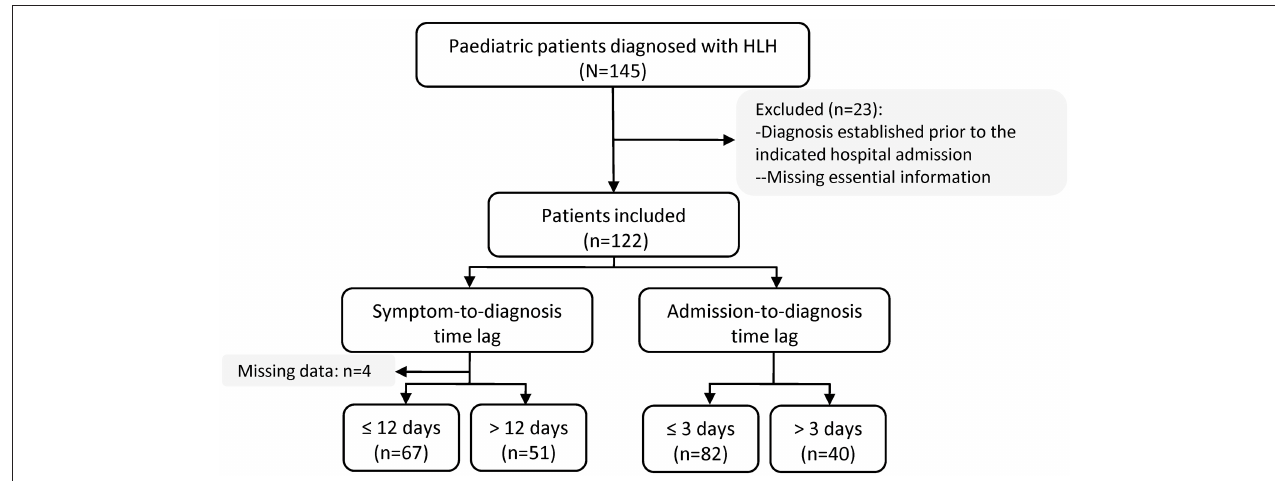
FIGURE 1 | Flow diagram of study population. HLH, haemophagocytic lymphohistiocytosis.